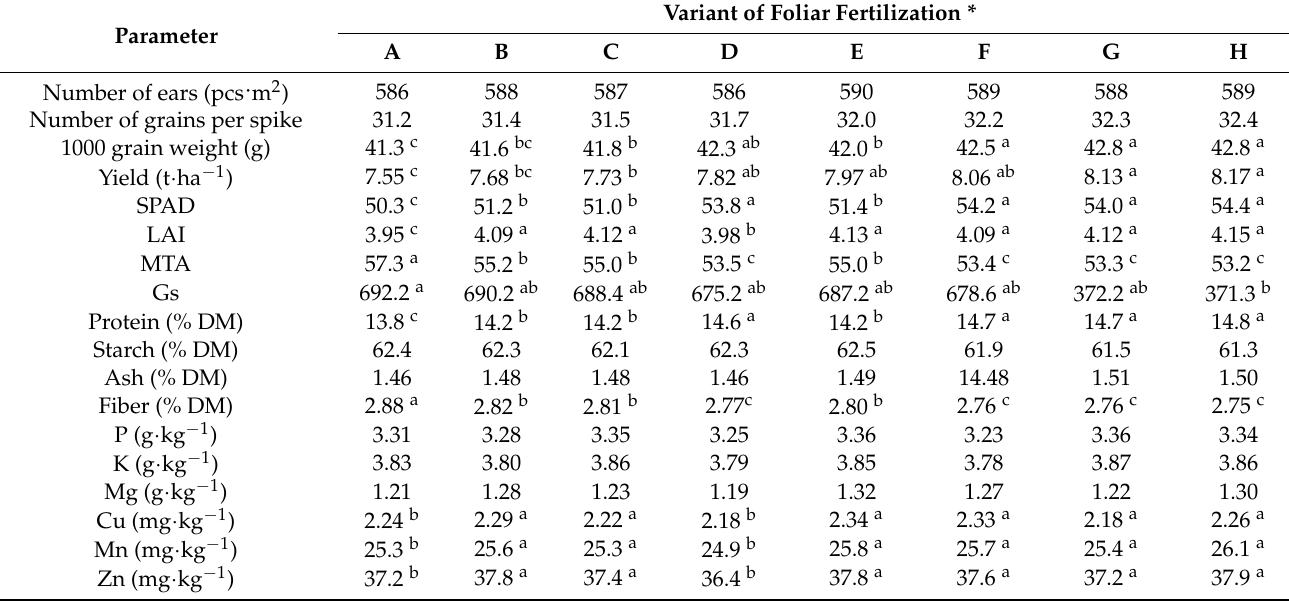
Figure 1. Weather conditions. Table 2. Features and parameters of winter wheat (mean for year).